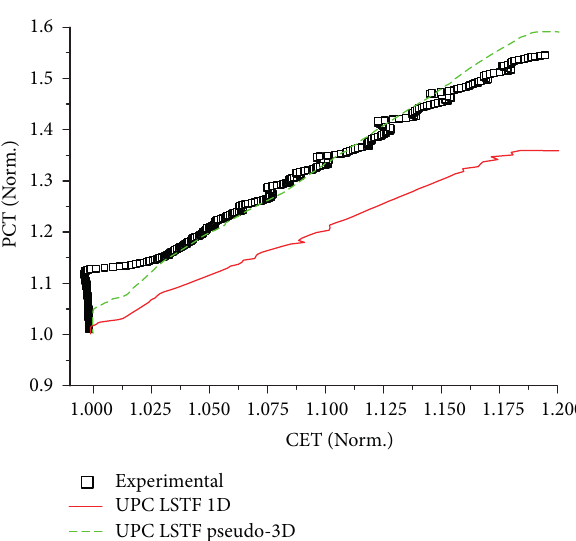
Figure 17: PCT versus CET curve during high-pressure transient phase.